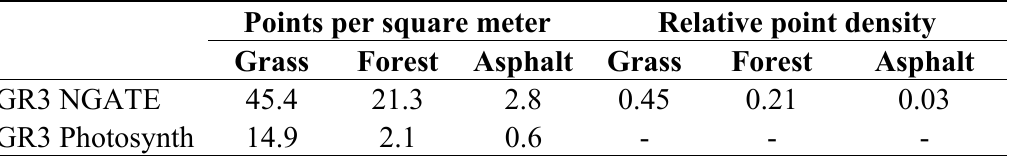
Table 6. Points per square meter and relative point densities (Equation (2)) in 3 m × 3 m areas in the point clouds created from Ricoh GR3 images using NGATE (a 10 cm point interval) and